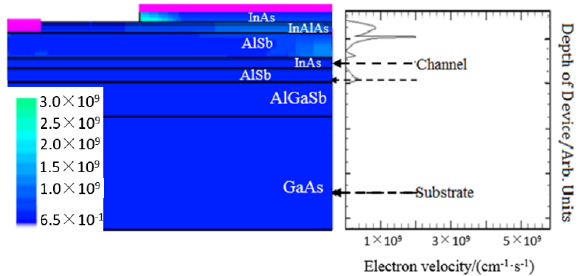
Figure 5. Distribution of electron velocity from simulation.